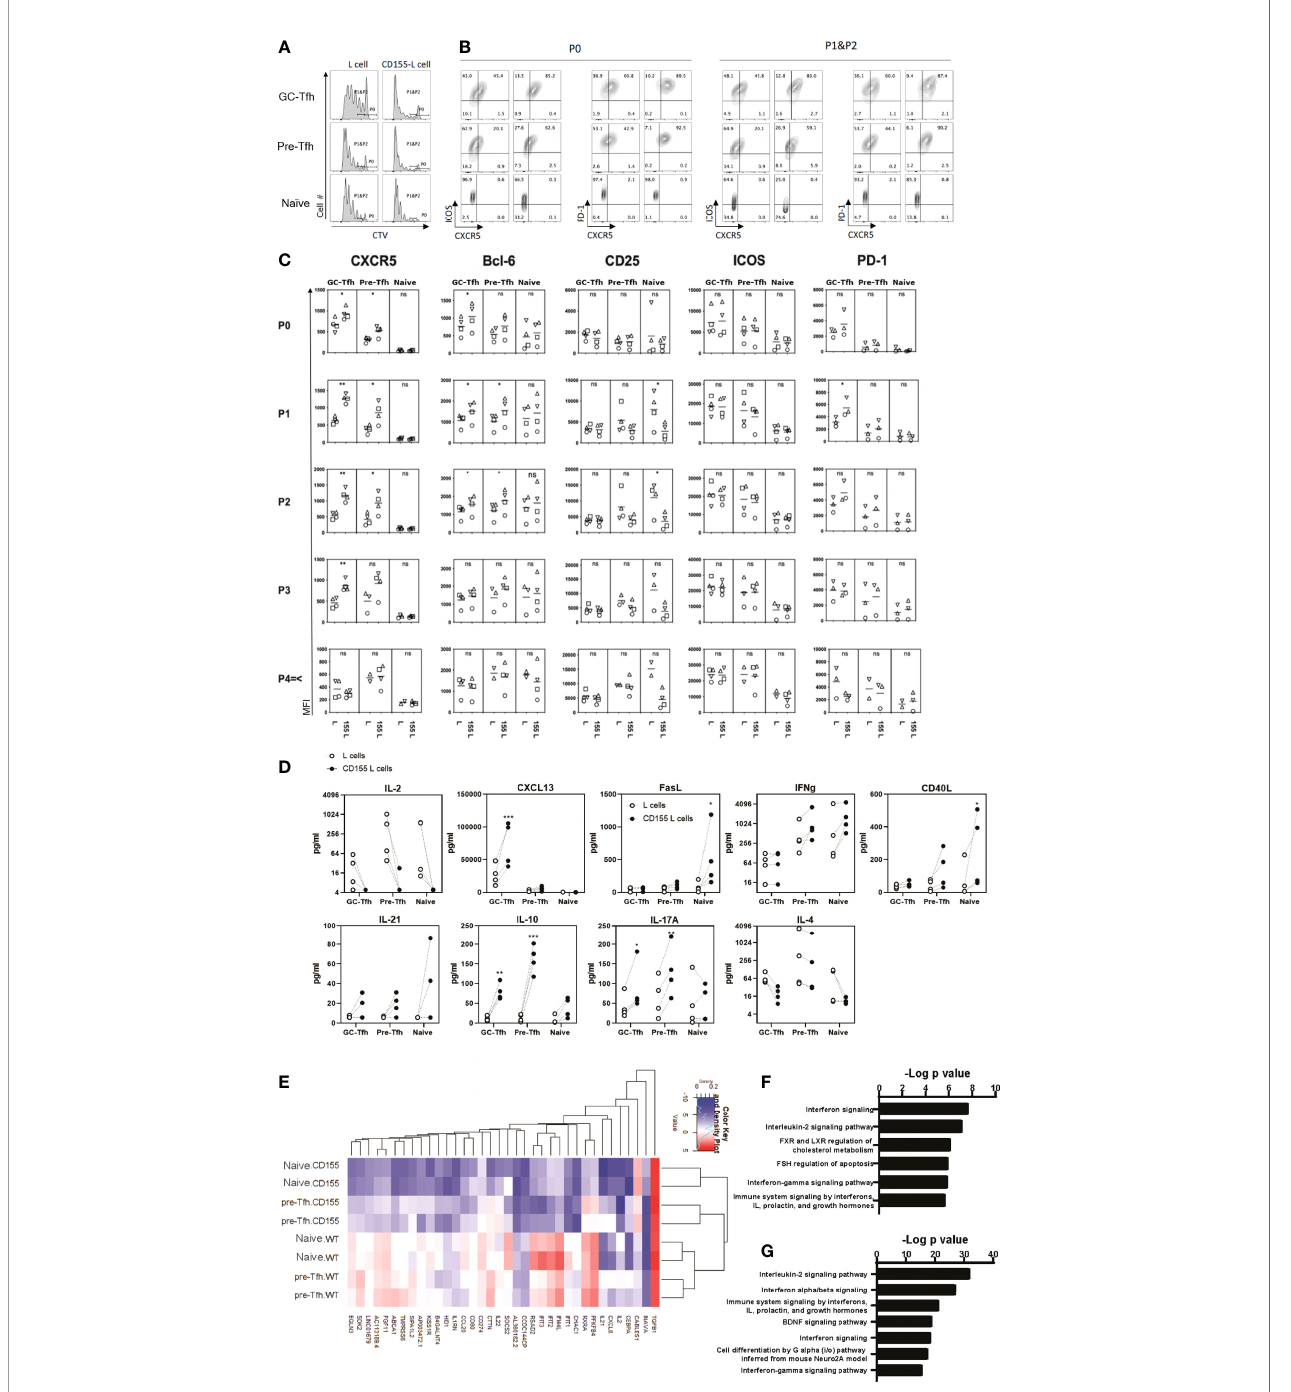
FIGURE 5 | CD155 costimulation promotes the early phase of Tfh cell differentiation. Tonsilar GC-Tfh, pre-Tfh, and naïve cells were stimulated with L cells or CD155 L cells coated with anti-CD3. (A) Cell proliferation assessed at day 5 by CTV dilution. (B) Phenotype assessed at day 5 by fl ow cytometry. Per stain each left panel was cultured with L cells; Right panels were cultured with CD155 + L cells as denoted in (A) . P0: undivided cells, P1&P2: divided cells one and two times. (C) CXCR5, Bcl-6, CD25, ICOS, and PD-1 expression was measured in proliferated (P1, P2, P3, and P4 ≤ ) and undivided (P0) GC-Tfh, pre-Tfh, and naïve cells stimulated with L cells or CD155 + L cells. (D) Cytokine concentration in culture supernatants is shown with dotted lines indicating matching donor samples (n= 4, 4 separate experiments). Paired t-test. *p <0.05; **p < 0.01; ***p < 0.001. (E) Top 38 most signi fi cantly different genes shown between CD155 + L cell and L cell stimulated naïve and pre-Tfh cells by RNAseq analysis (n= 2 donors). Pathway analysis for genes from (F) pre-Tfh or (G) naïve cells that were found to be signi fi cantly different when stimulated with L cells or CD155 + L cells by RNAseq (enrichR (39): BioPlanet 2019). ns, not signi fi